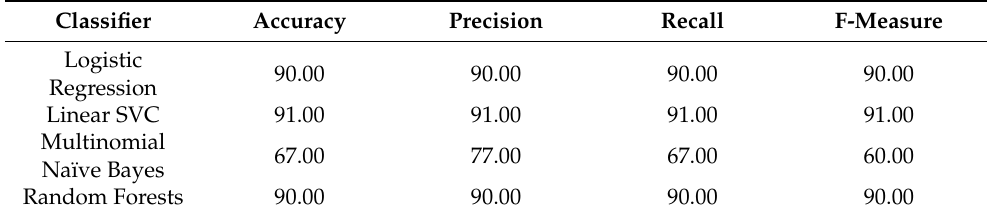
Table 3. Sample education-related UAE Twitter Chatter Data.